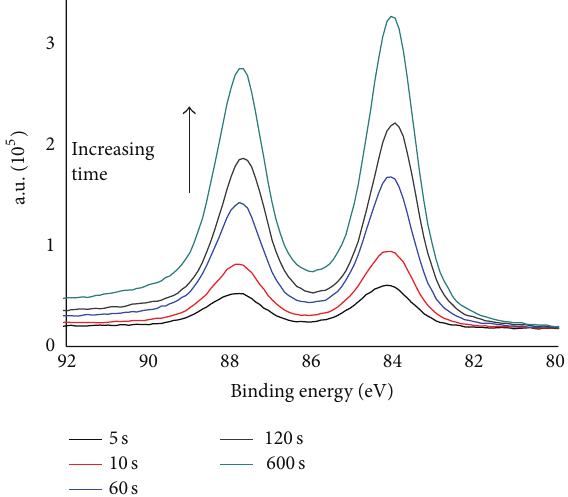
Figure 3: XPS spectra in the Au 4f 7/2 region for GaAs (100) samples immersed in 0.1mM HAuCl 4 for increasing